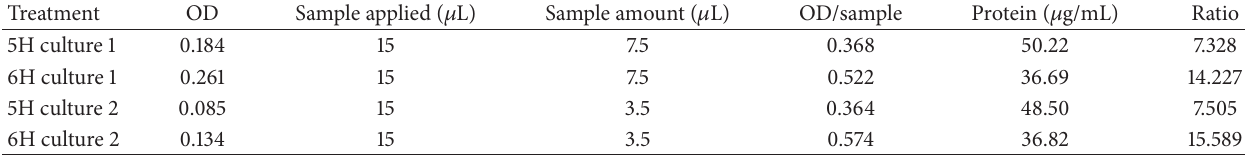
Table 1: Uncalibrated optical density (OD) measurements of the Tg bands from Figure 3 corresponding to exosome pellets are presented here. The “sample applied” refers to the total volume applied to the gel and “sample amount” refers to the volume of the original dissolved exosome pellet present within that applied sample. Optical density measurements are normalized to the sample volumes and the ratio of Tg optical density to total protein concentration of the exosome samples is calculated and represented here multiplied by a factor of 1000. Treatment OD Sample applied ( 𝜇 L) Sample amount ( 𝜇 L) OD/sample Protein ( 𝜇 g/mL)